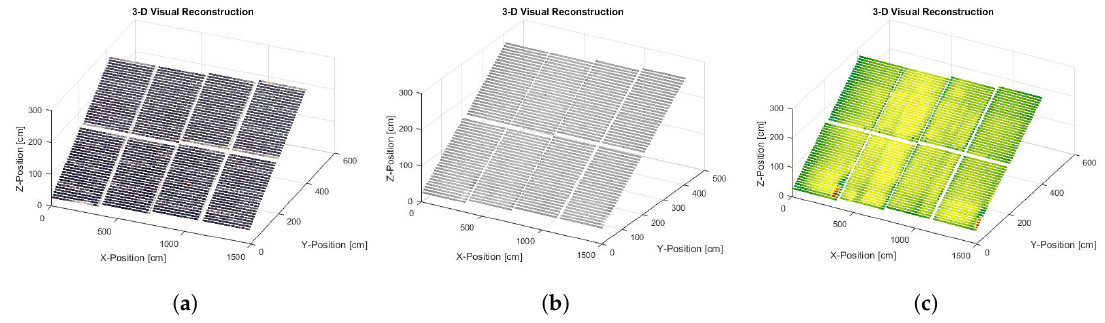
Figure 13. Full 3D thermal reconstruction of a photovoltaic module. ( a ) Visual reconstruction. ( b ) Thermal reconstruction (Gray scale mode). ( c ) Thermal reconstruction (High contrast